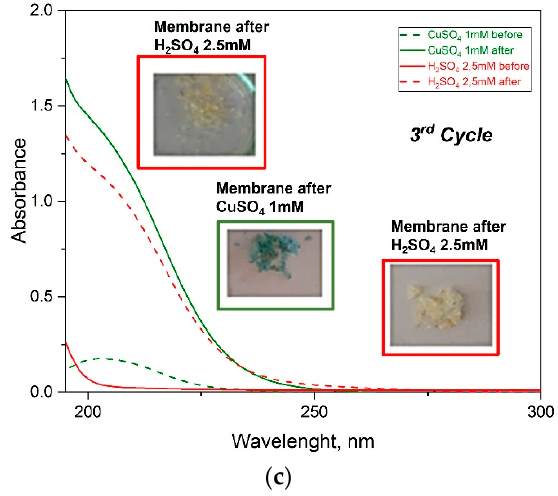
Figure 13. UV-vis spectra of adsorption–desorption studies of membrane Ch-NH 2 /P(DMAM-GMA) 8:2 for ( a ) first, ( b ) second and ( c ) third cycle.